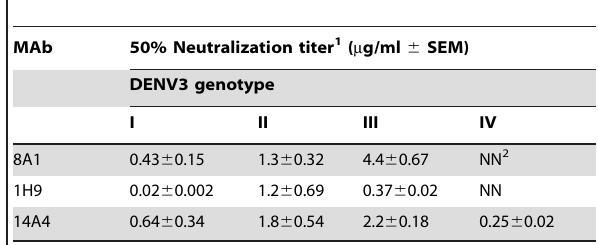
Table 3. Neutralization of DENV3 genotypes by EDIII MAbs.